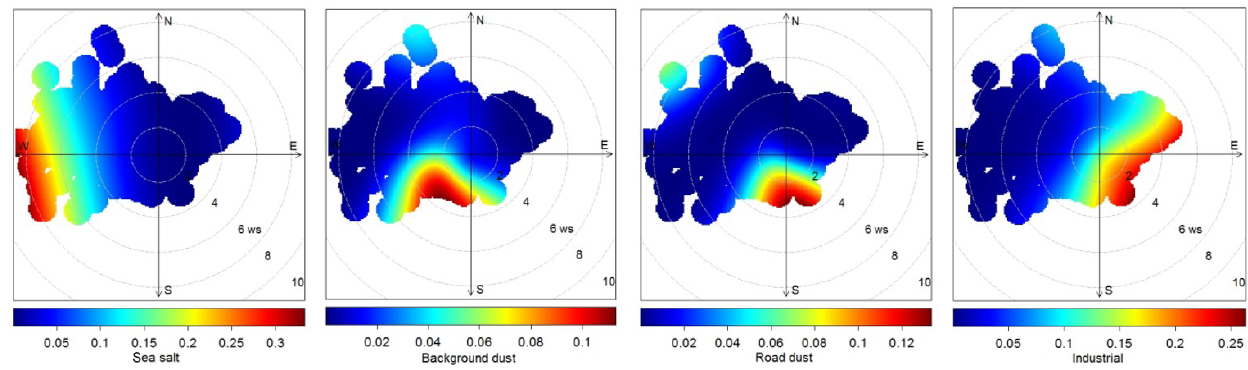
Figure 5. CBPF analysis (at 90th percentile) of factors in terms of wind speed (ms − 1 ) and wind direction. The colour code represents the probability of the factor